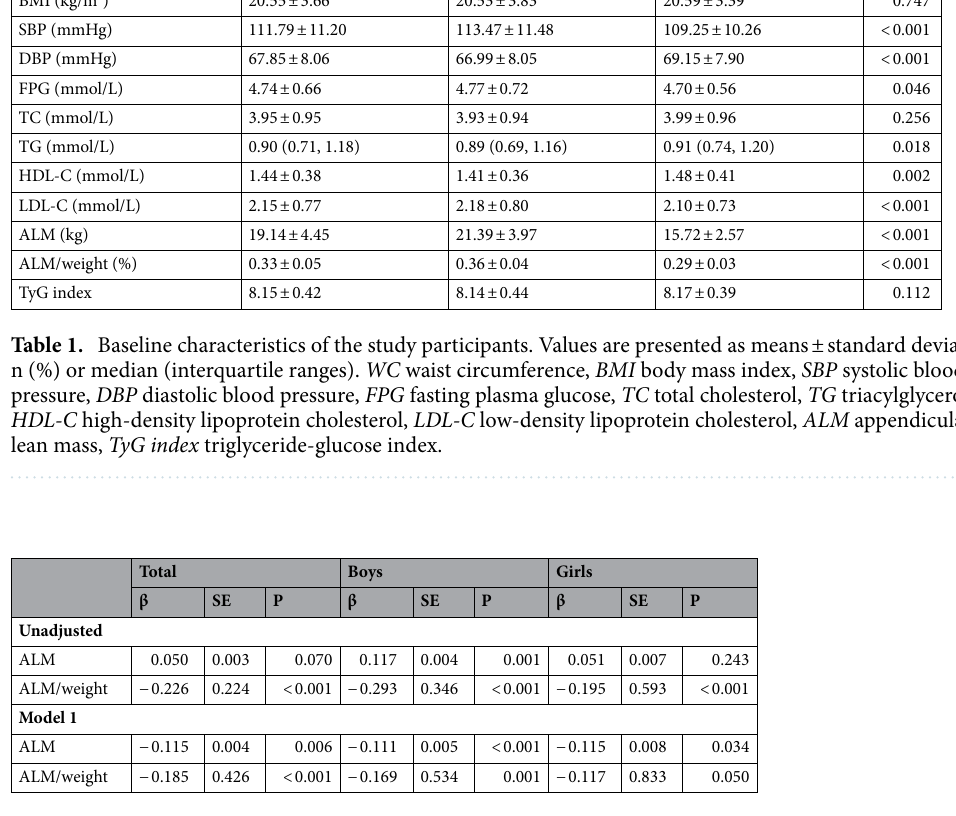
Table 2. Multivariate liner regression analyses to evaluate the independent associations of TyG index with ALM and ALM/weight. The Model 1 is adjusted for age, BMI. ALM appendicular lean mass, TyG index triglyceride-glucose index.